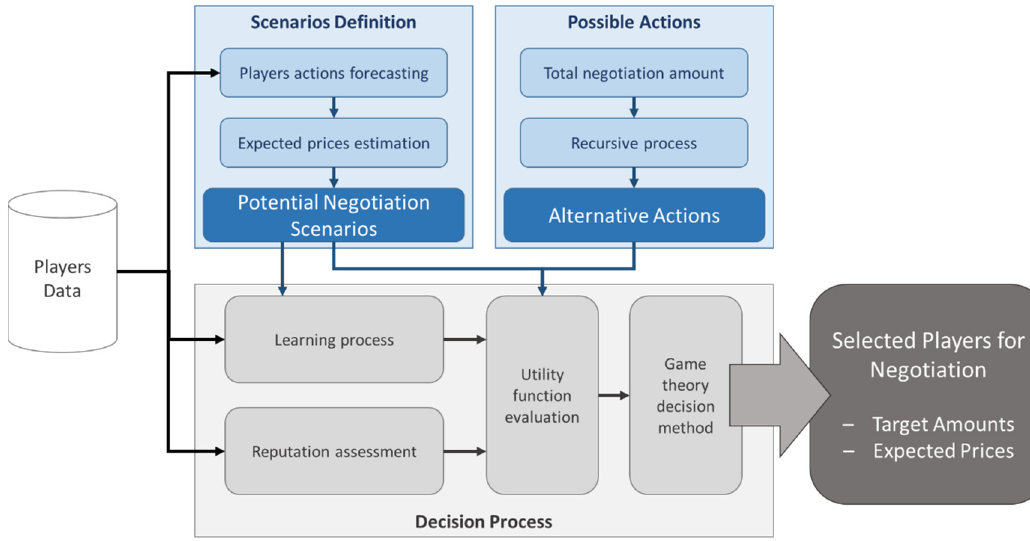
Figure 1. Decision process of the proposed